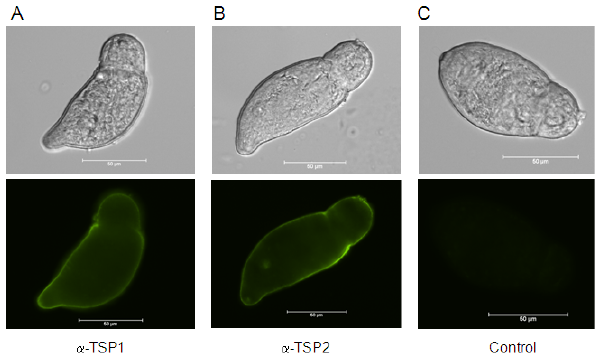
Figure 2. Expression of Sm -TSP-1 or Sm -TSP-2 on the surface of live schistosomula. Immunofluorescent labelling of live 3 h schisto- somula with antisera raised against Sm -TSP-1 (A) and Sm -TSP-2 (B), and control pre-immune serum (C) followed by anti-mouse Ig-FITC. Schistosomula are shown in bright-field and FITC stained. Sca- le=50 m m.